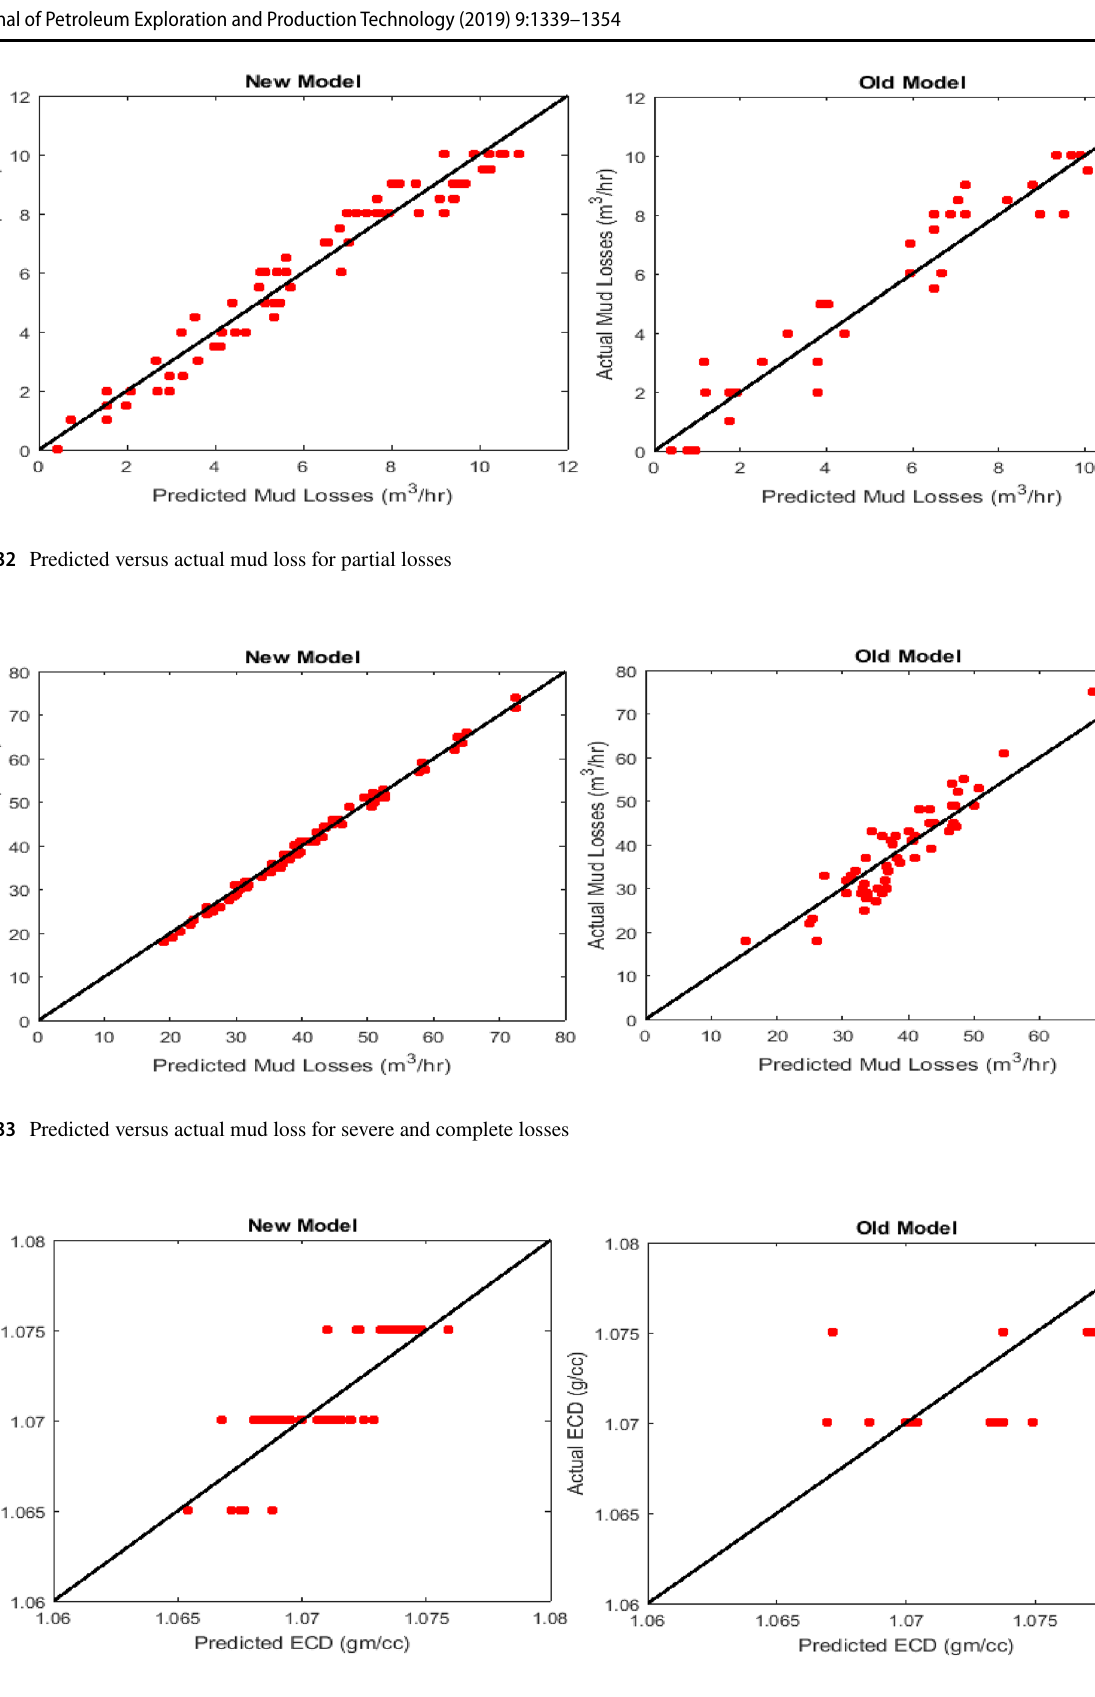
Fig. 34 Predicted versus actual ECD for partial